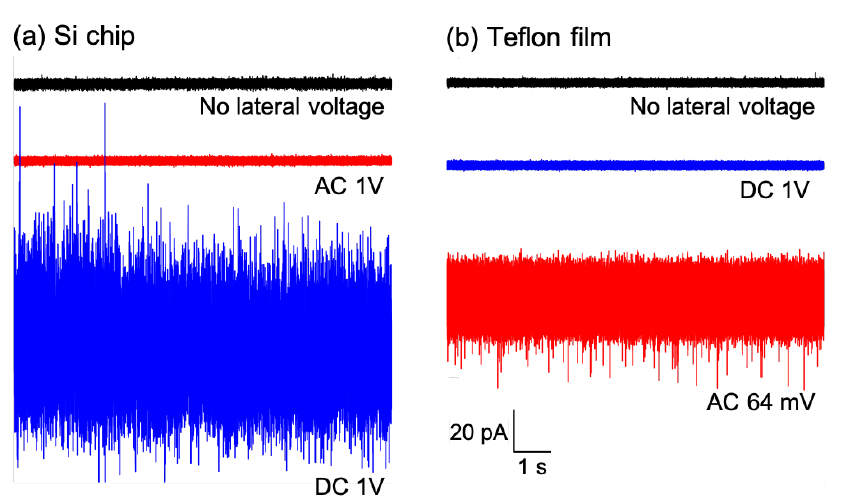
Figure 8. Transmembrane current noise from Si chip ( a )- and Teflon film ( b )-based BLM systems. Noise levels without lateral voltage (black), with AC lateral voltage (red), and with DC lateral voltage (blue). Reprinted with modification from Ref. [11]. Copyright 2022 The Royal Society of Chem- istry.